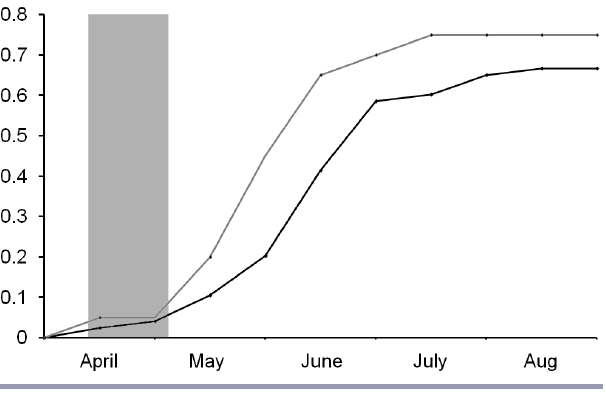
Fig. 4 . The timing of Tristan Albatross ( Diomedea dabbenena ) chick failures in the Gonydale study colony (103 chicks, black) and for the subsample of frequently checked chicks within the colony (20 chicks, grey) in 2014. Chick mortality represented as a cumulative percentage (y axis). The shaded area represents the time when chicks are first left alone.